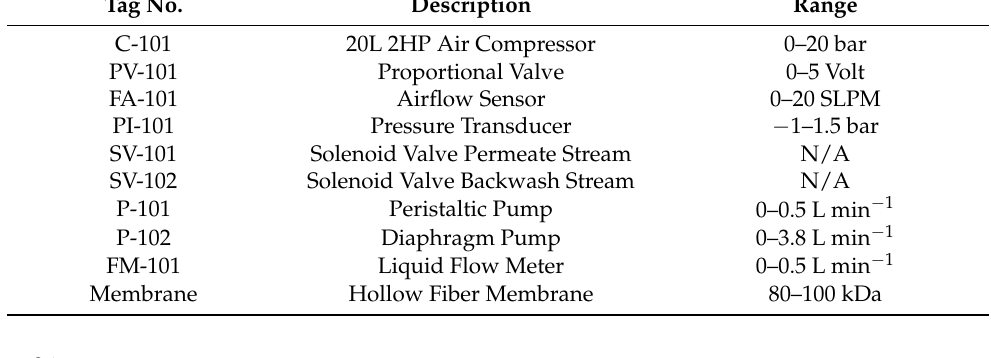
Table 1. List of instruments in the pilot plant. Tag No.